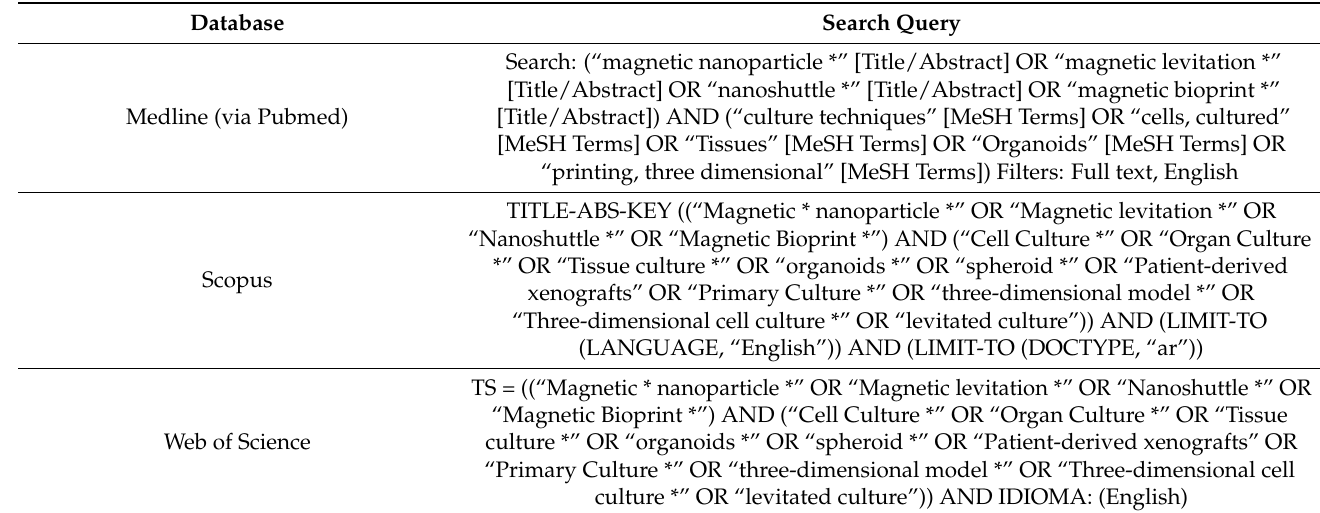
Table 1. Search strategy